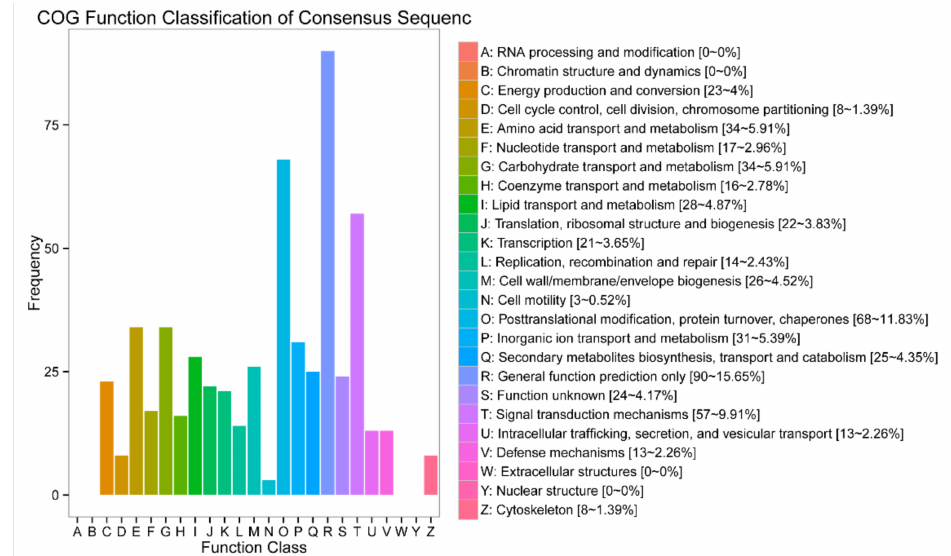
Figure 3. COG classification of all DEGs. COG classification is an important aspect of the functional annotation of DEGs. Among all COG terms, “R: General function prediction only” (90 DEGs, 15.65%), “O: Posttranslational modification, protein tumor, chaperones” (68 DEGs, 11.83%), and “T: Signal transduction mechanisms” (57 DEGs, 9.91%) classified the most DEGs.